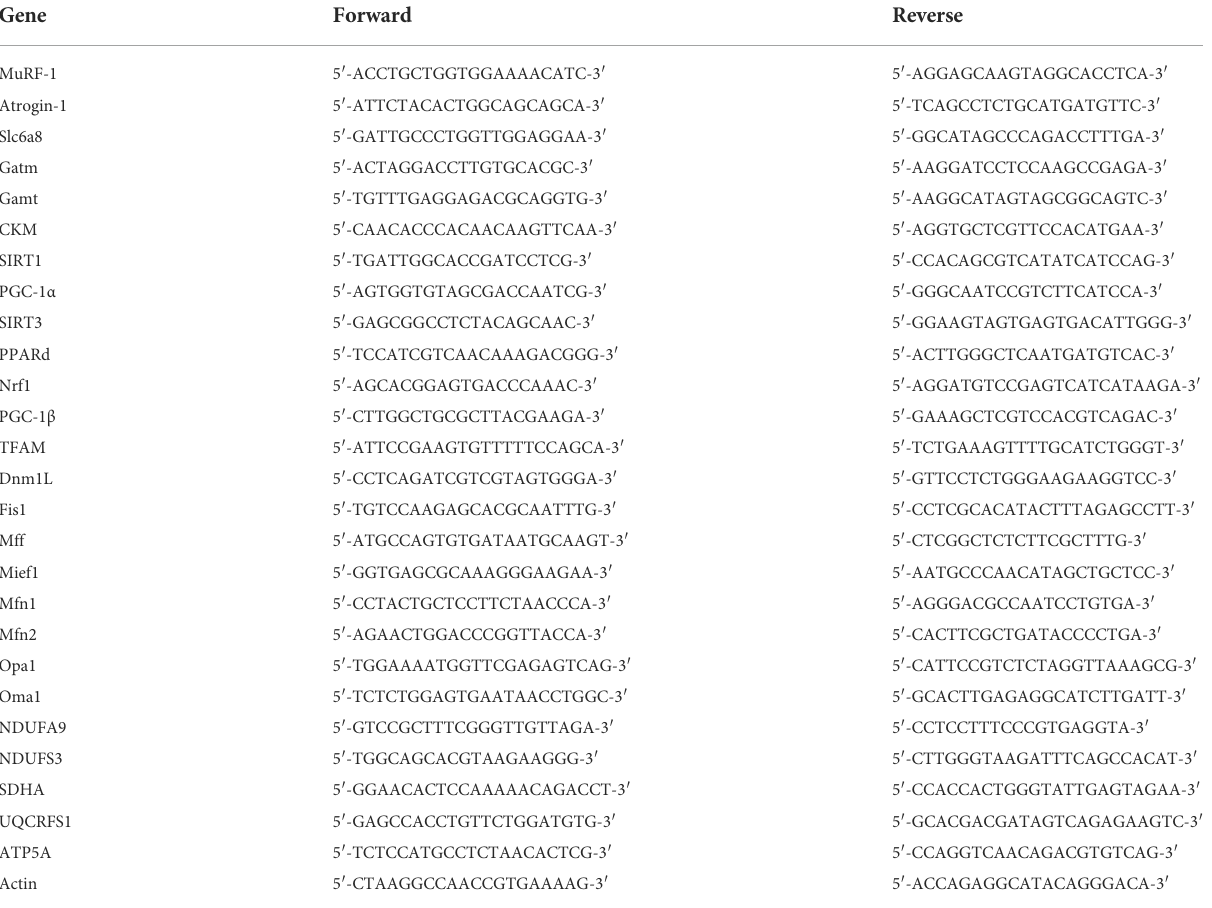
TABLE 1 Sequences of primers used in qRT –